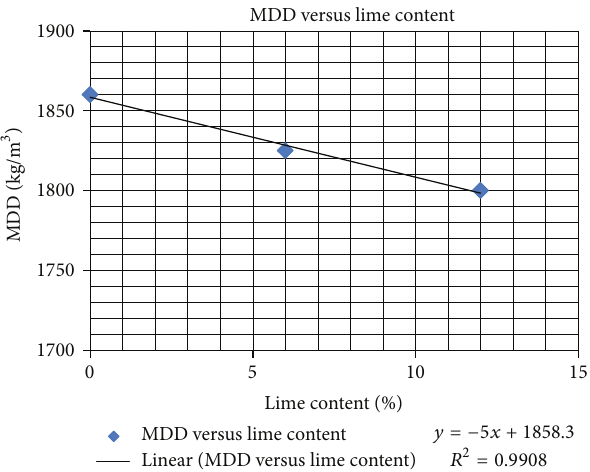
Figure 8: Relationship between maximum dry density and lime content for stabilized WDA.